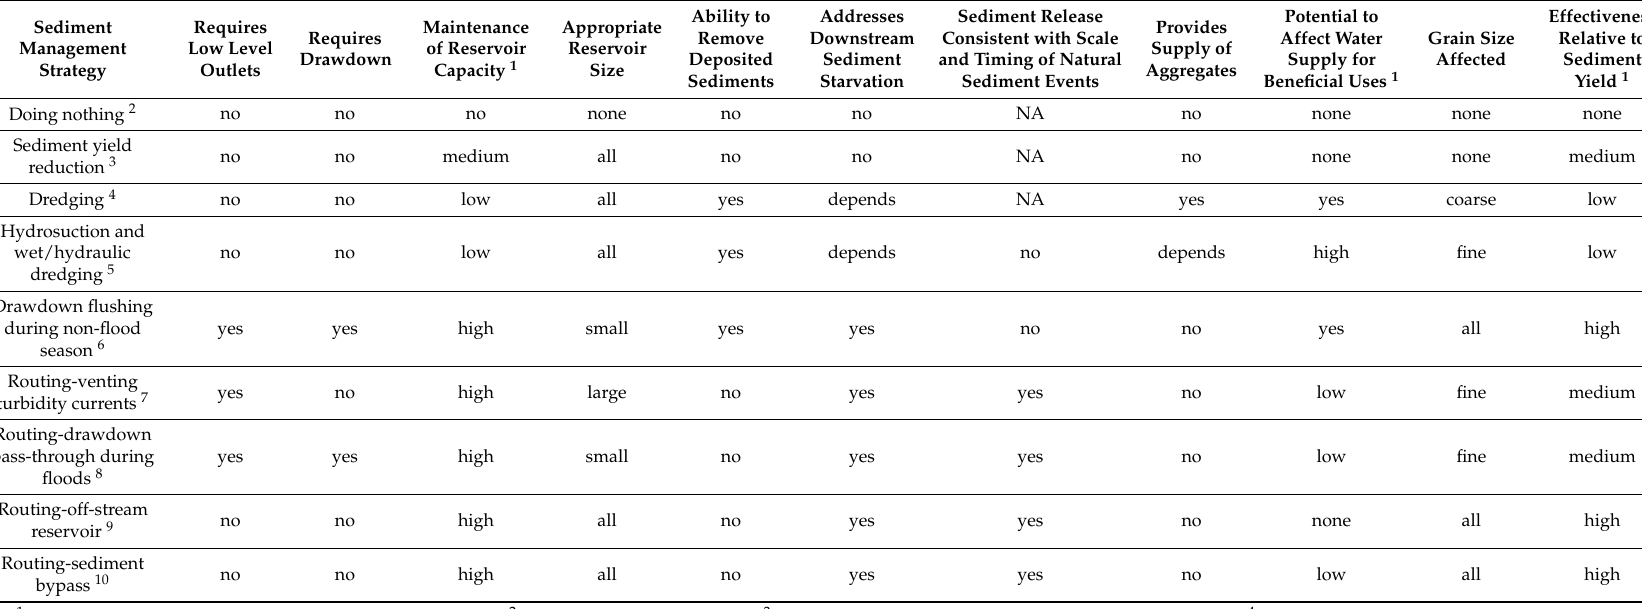
Table 1. Characteristics and limitations of sediment management strategies. For strategies identified as “depends,” the local decisions about the strategy determine if the strategy contributes to the characteristic (Annandale et al. [8]; Morris and Fan [9]; Kondolf et al.